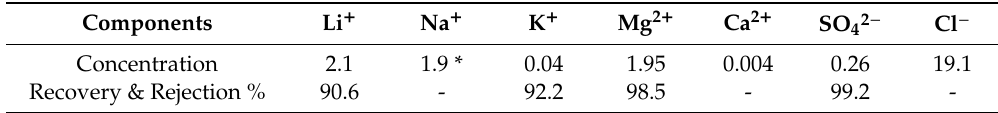
Table 2. The concentration of the main ions in the obtained anolyte (g · L − 1 ). Components